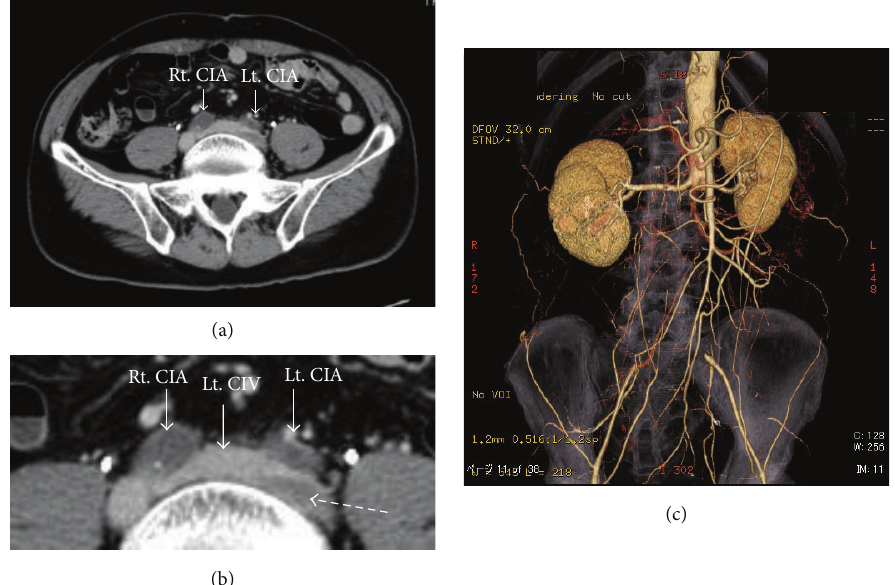
Figure 2: (a) The left common iliac vein (Lt. CIV) was compressed by the left common iliac artery (Lt. CIA) resulting in formation of a venous thrombus at this point. (b) The thrombus was observed in left common iliac vein (dotted arrow). (c) CT showed that the terminal aorta was occluded from the level of renal artery to the bilateral common iliac